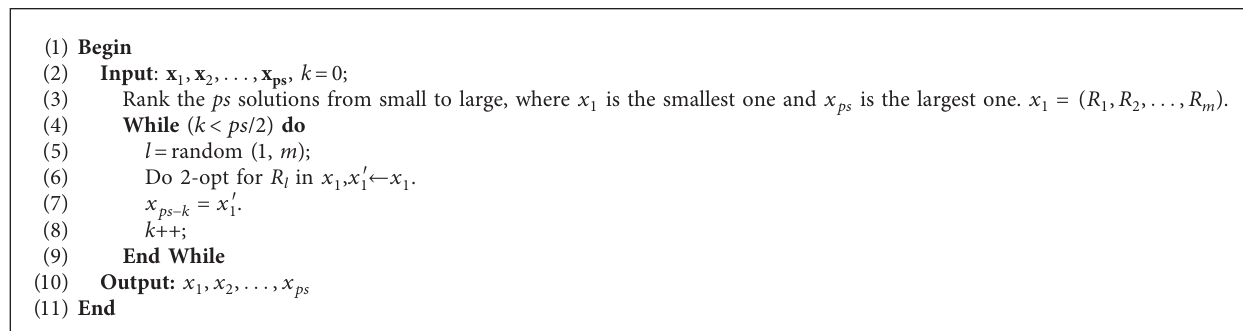
Figure 4: Relocation of a pair of routes.